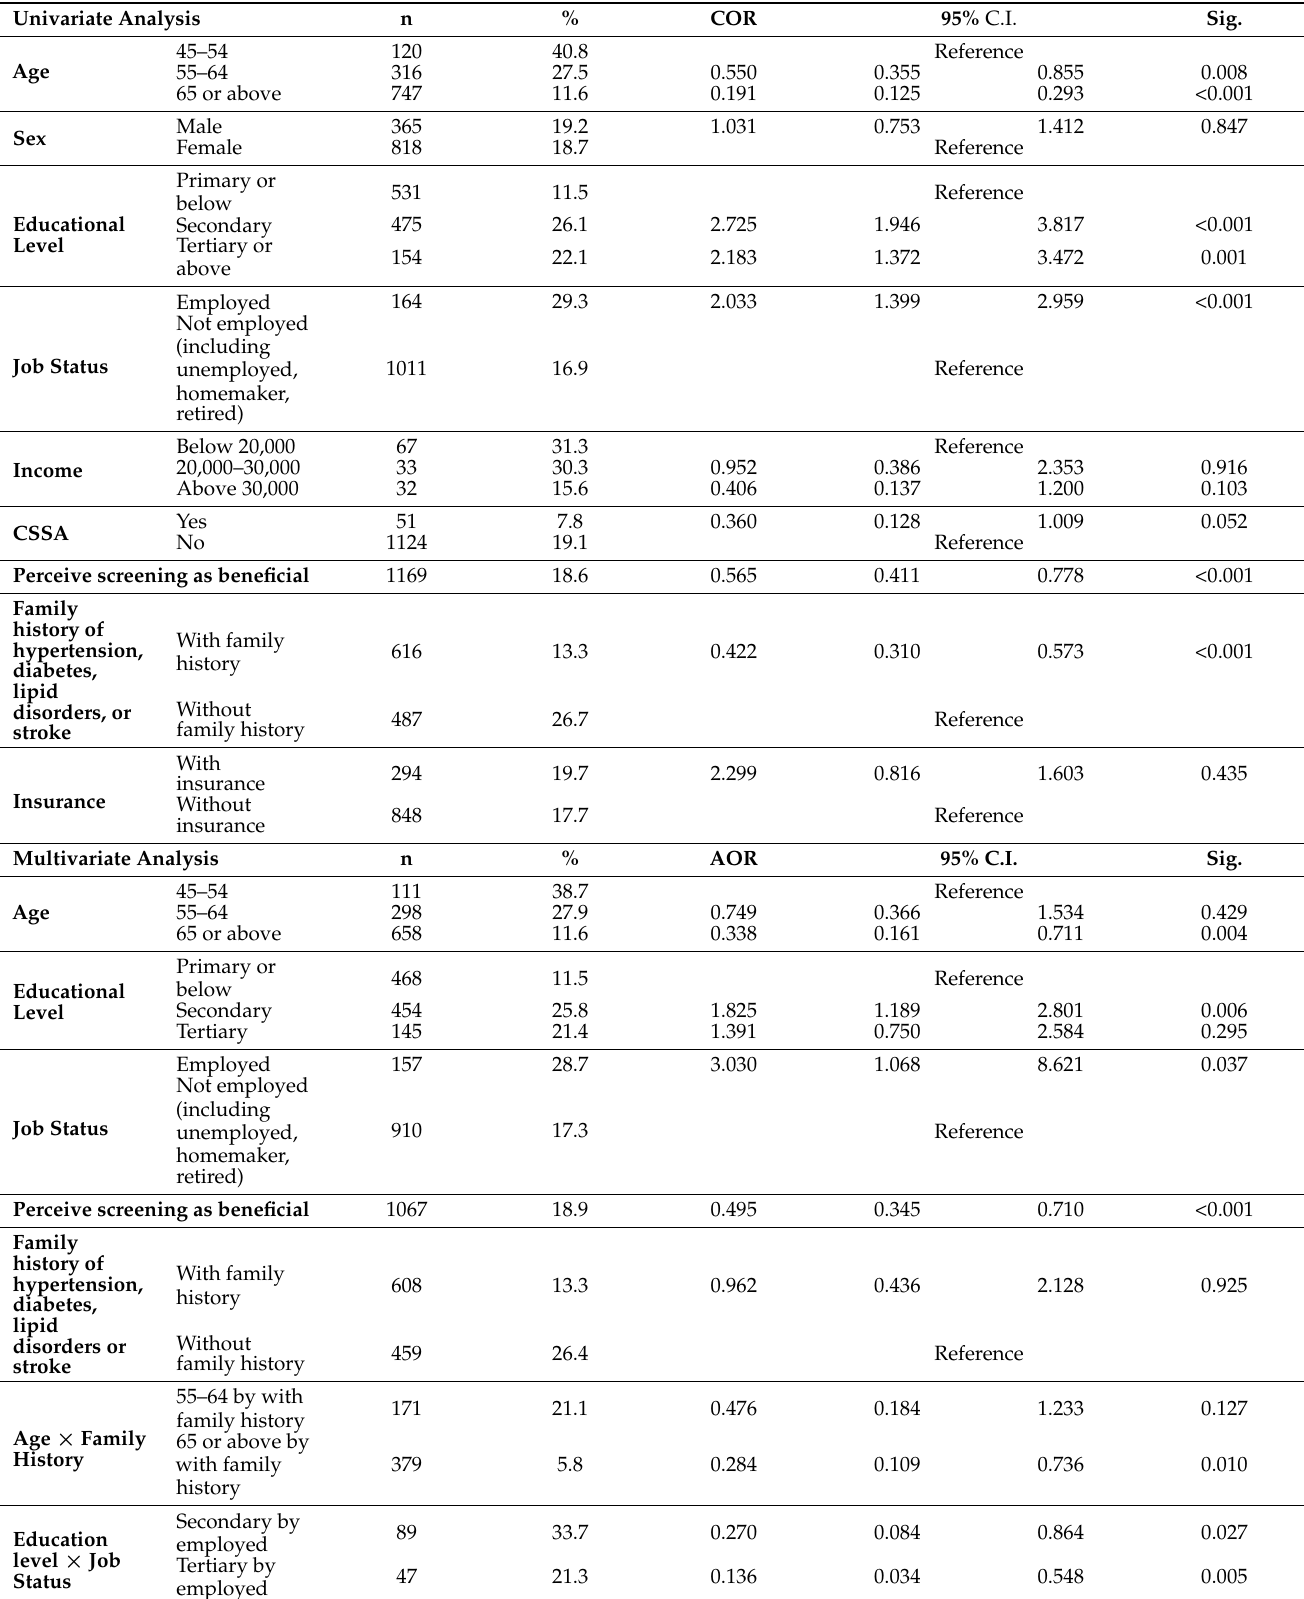
Table 2. Factors associated with not screening for at least one